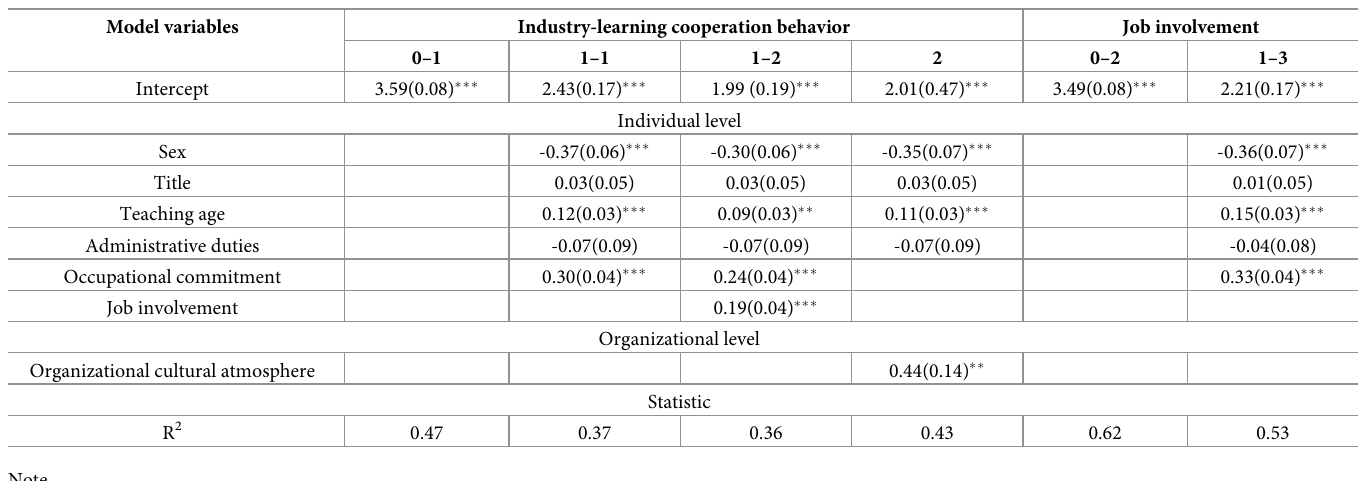
Table 5. Main effect test results.